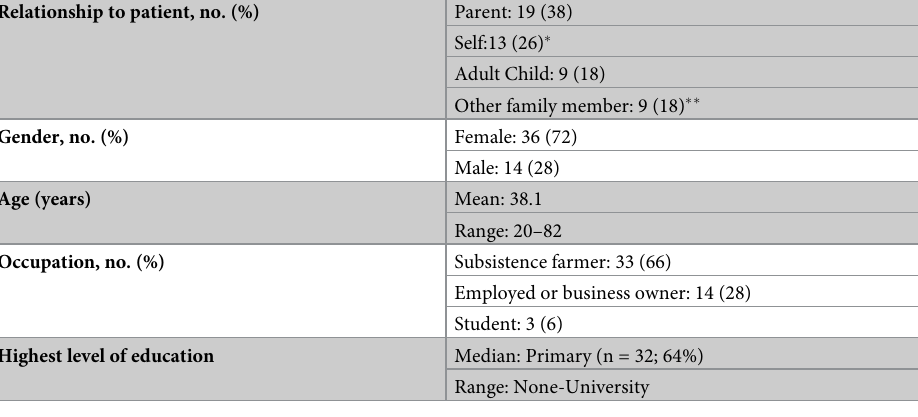
All patients included in the study reported the acute onset of new symptoms or acute worsen- ing of previously recognized symptoms leading to ED presentation. Delays were quantified as the duration of the patient’s CC and the time from recognition of a severe condition necessitat- ing EC (by the patient or their caregiver) to presentation at the ED. Both are presented in Table 3. The most notable trend related to treatment delay at the ED was history of chronic disease. ED patients with acute presentations and history of underlying chronic conditions experienced substantially longer delays in reaching the ED than otherwise healthy patients. Among chronically ill patients, recognition of acute symptoms needing EC ranged from 12 hours– 14 days prior to arriving at the ED, with an average of 6 days. For all patients included in the study the mean duration from recognition of symptoms necessitating EC to presenta- tion at the ED as 1 day. Patients with chronic disease and their caregivers reported challenges to decision-making including perceptions that: